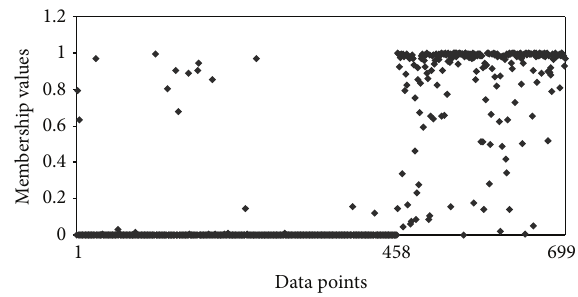
Figure 3: Membership for different data points for the malignant cluster by using Ahmad and Dey [22] distance measure for 𝑚 = 1.1 . The first 458 data points are benign and next 241 data points are malignant.